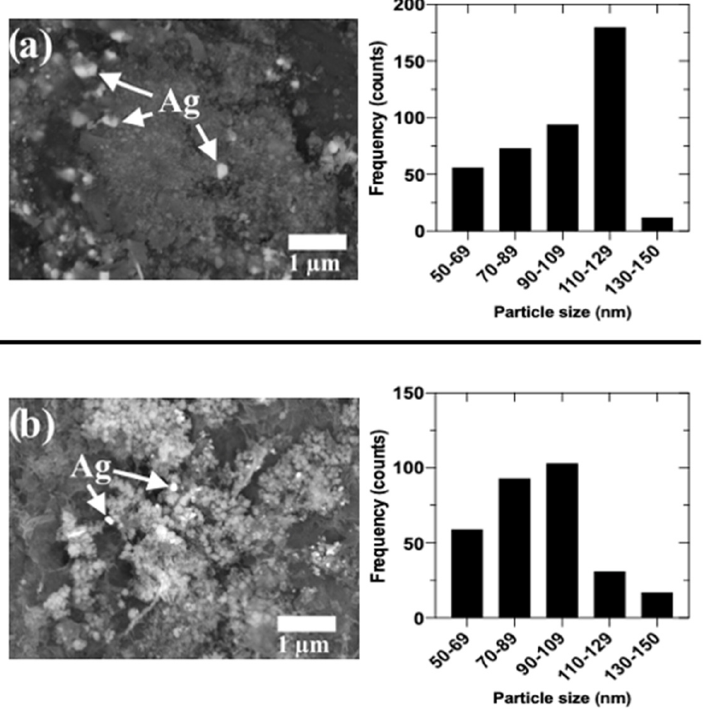
Figure 13. SEM images (20,000 × ) and particle size distribution of Ag as a part of the hybrid ZnO/Ag deposits on Mg-Ca0.3 surfaces, electroless achieved from aqueous solution (10 − 3 M, at 21 °C): ( a ) ZnO/AgNO 3 and ( b ) Zn(NO 3 ) 2 /AgNO 3 solutions.